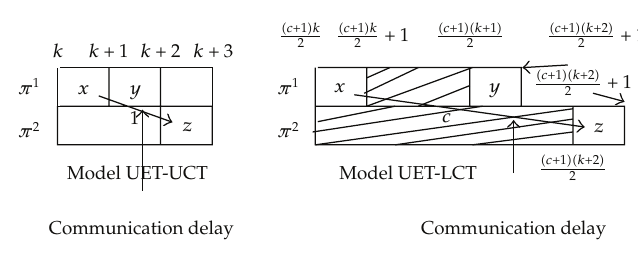
Figure 10: Illustration of the notion of